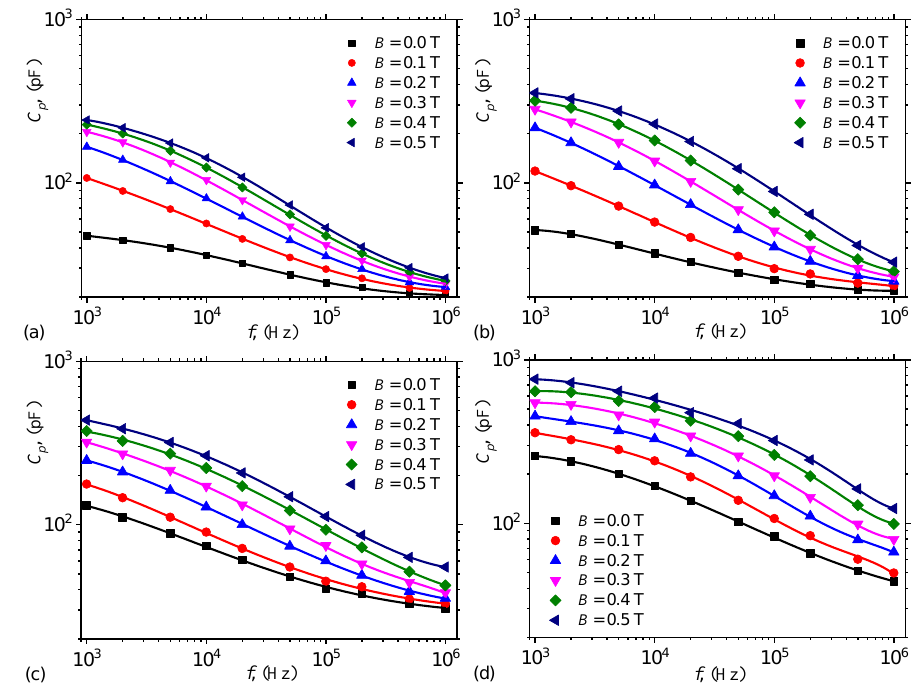
Figure 4. Variation of capacitance C p with frequency f , at fixed values of magnetic flux density B . ( a ) hMAC. ( b ) hEMAC 1 . ( c ) hEMAC 2 . ( d ) hEMAC 3 .